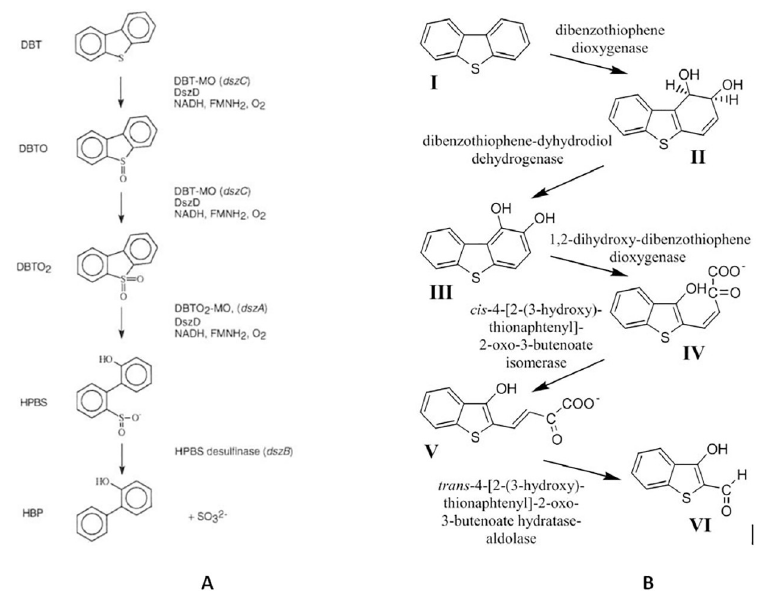
Fig 4. Metabolism pathways. (A) Biodesulfurization versus (B) biodegradation pathways.